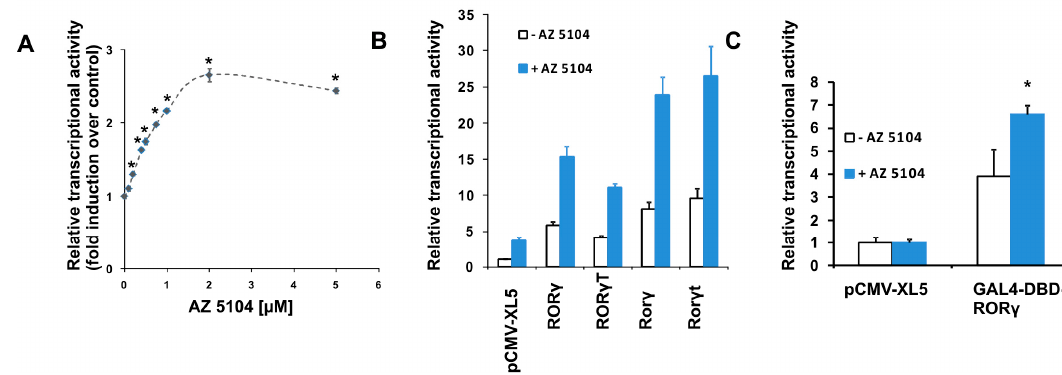
Figure 3. Individual biological e ff ects of AZ5104. ( A ) AZ5104 induces ROR γ -dependent transcription in the ROR γ -HepG2 reporter cell line. Mean ± SD, n = 6. ( B ) AZ5104 potentiates the activity of human ROR γ and ROR γ T and mouse Ror γ and Ror γ t overexpressed in the ROR γ -HepG2 reporter cell line. Mean ± SD, n = 6. Luciferase activity was standardized per corresponding secreted alkaline phosphatase activity, which was used as transfection e ffi ciency control. Results were normalized to the activity of nontreated, pCMV-XL5-transfected cells. ( C ) AZ5104 induces the activity of the GAL4-DBD ROR γ fusion protein in the HepG2-pGL4.35 reporter cell line. Mean ± SD, n = 6. * p < 0.05 compared with control treatment. Luciferase activity was standardized per corresponding secreted alkaline phosphatase activity, which was used as transfection e ffi ciency control. Results were normalized to the activity of nontreated, pCMV-XL5-transfected cells.